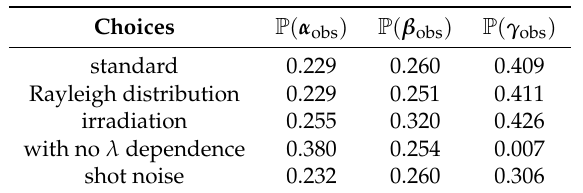
Table 2. Display of the insensitivity of the probabilities of our observables to the choices made regarding planet formation. In addition to the options displayed, they may have been combined, but this would belabor the